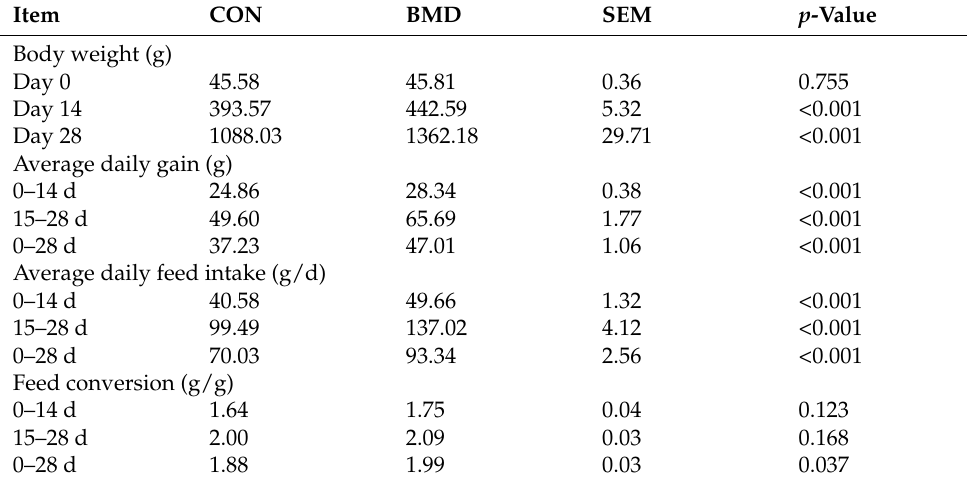
Table 1. The growth performance of broilers in the CON and BMD groups.